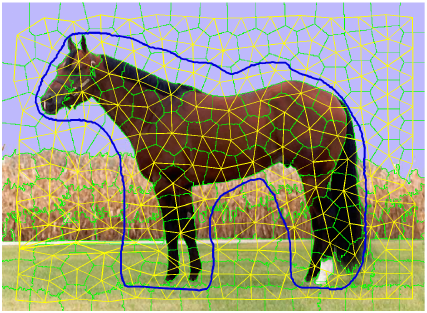
Figure 2: The graph model with superpixel segmentation of an image. Every superpixel is represented by a node, with the green curves as superpixel boundaries, the yellow lines as the edges connecting adjacency nodes. The blue curve represents a cut of the